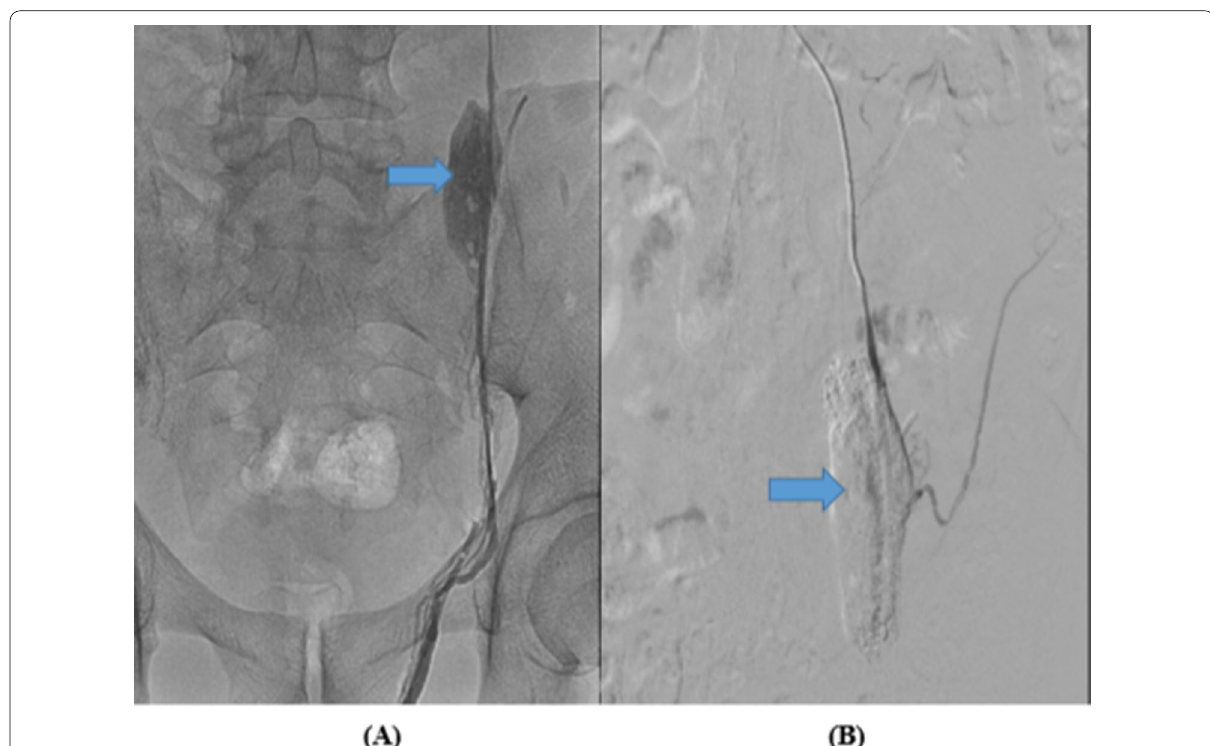
Fig. 8 A Venous dissection (blue arrow), B post sclerotherapy showing dissection occlusion (blue arrow), in addition to cessation of left gonadal venous opacification with no collaterals or reflux